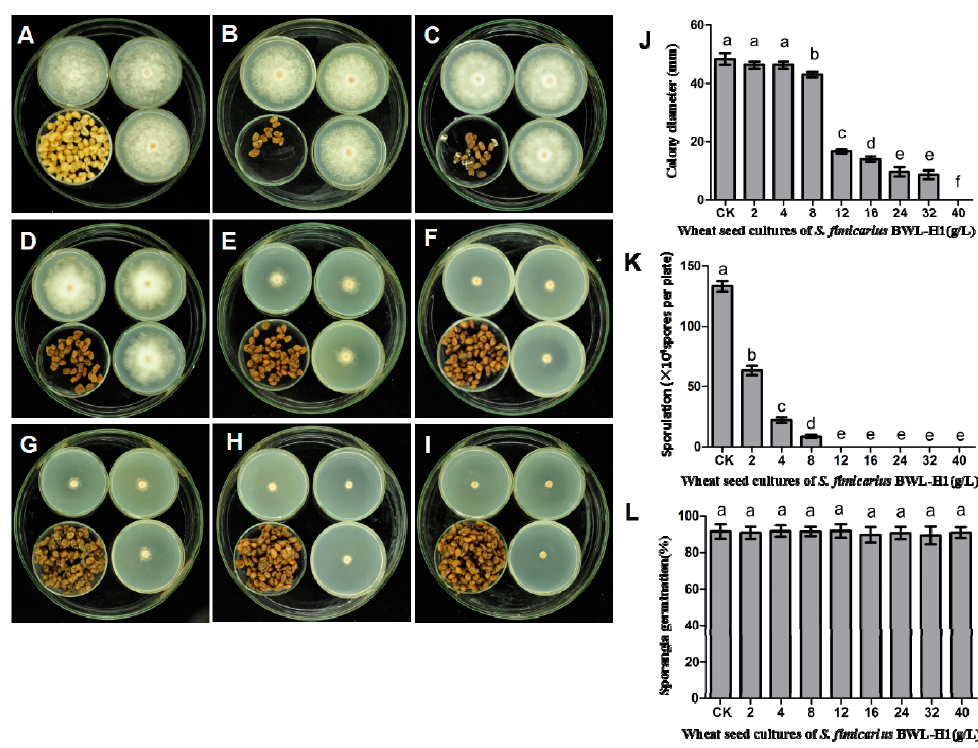
Figure 1. Suppression of P. litchii mycelial growth, sporangial production and germination by S. fimicarius BWL-H1volatiles. P. litchii was fumigated with 16 g/L of wheat seeds without S. fimicarius BWL-H1 culture ( A ); or with various amounts (2, 4, 8, 12, 16, 24, 32, 40 g/L) of wheat seed culture of S. fimicarius BWL-H1 ( B – I ) for 6 d and photographed. Barchart represents mean ± S.E. of colony diameter ( J ); sporangial production ( K ); or percentage of sporangia germination ( L ); grown as in ( A – I ). CK represents unfumigated control as shown in ( A ). For each instance, three independent experiments with triplicates were performed and values followed by different letters were significantly different ( p < 0.05).